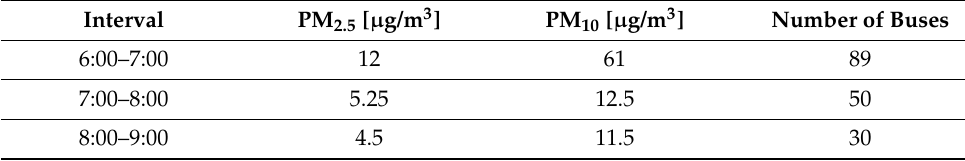
Table 3. Hourly particulate emissions at bus